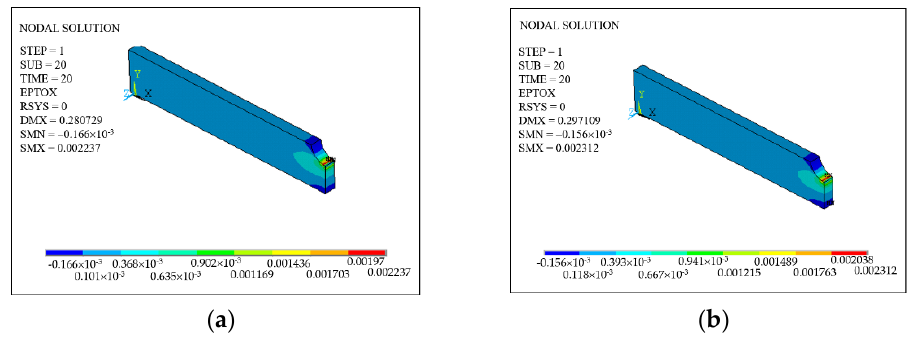
Figure 1. Notched sheet and nozzle finite element model.